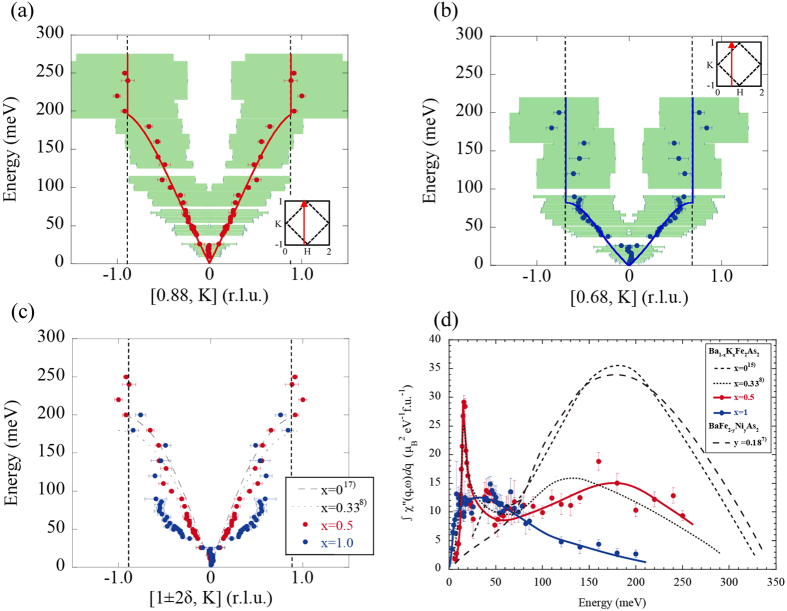
Dispersions of spin excitations for Ba0.5K0.5Fe2As2 and KFe2As2 along transverse direction.(a–c) Spin excitation dispersions of Ba0.5K0.5Fe2As2 (red) and KFe2As2 (blue) at T = 6K plotted as filled circles. The horizontal and vertical lengths of the green rectangles represent the full width at half maximum of the Gaussian fits of the constant-energy spectrum and the energy range in the fitting, respectively. Scan directions are depicted by the arrows in the insets. The dashed and dotted lines in (c) are dispersion of BaFe2As2 at T = 7K (ref. 17) and Ba0.67K0.33Fe2As2 at T = 9 K (ref. 8), respectively. The vertical dashed lines depict the magnetic zone boundaries for Ba0.5K0.5Fe2As2. (d) Energy dependence of ∫χ”(q, 3ω)dq for Ba0.5K0.5Fe2As2 (filled red circles) and KFe2As2 (filled blue circles) at T = 6 K. The solid lines are a guide to the eye. The black dashed lines depict ∫χ”(q, ω)dq for BaFe2As2 at T = 5 K (ref. 15), Ba0.67K0.33Fe2As2 at T = 9 K (ref. 8) and BaFe1.82Ni0.18As2 (ref. 7) at T = 5 K, respectively.